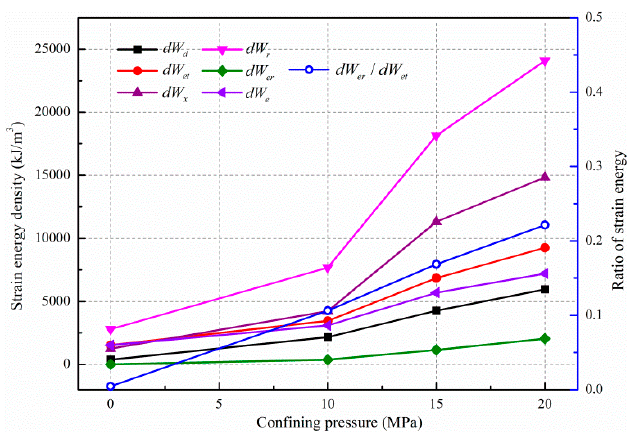
Figure 12. Strain energy density and strain energy ratio under different confining pressure.